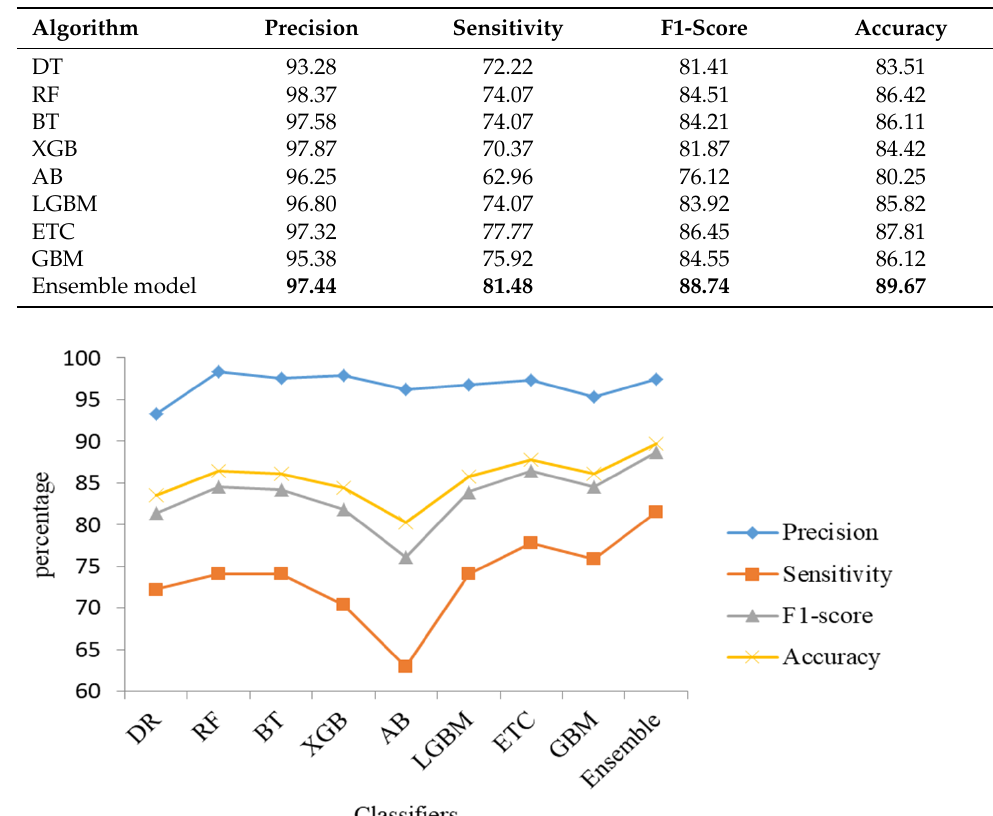
Figure 11. Test results of various classifiers with respect to hybrid features.